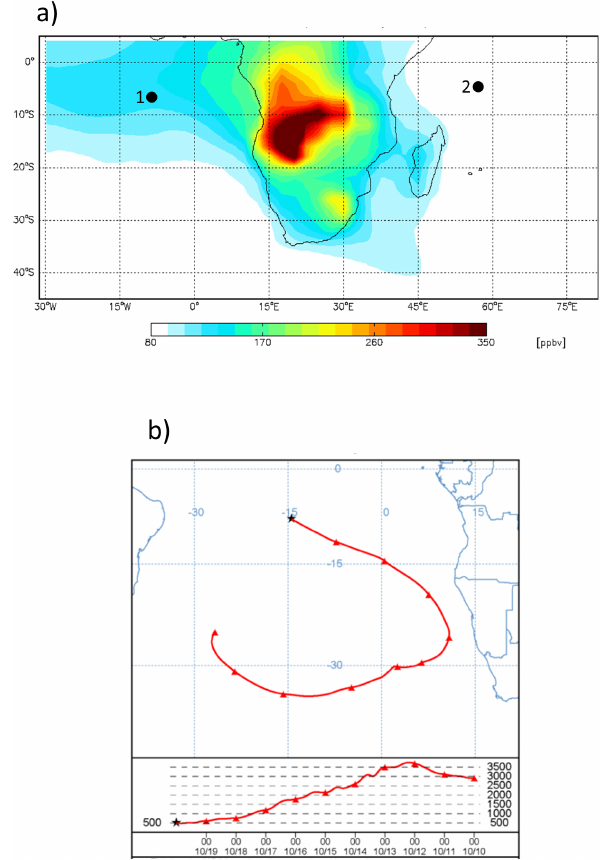
Figure 4. (a) Monthly averaged surface CO distribution over south- ern Africa and Atlantic Ocean in September 2005. The station lo- cations (refer to Fig. 1 for station number) are also shown. (b) A typical 10-day backward trajectory (launched on 20 October 2003) showing recirculation of air mass over South Atlantic